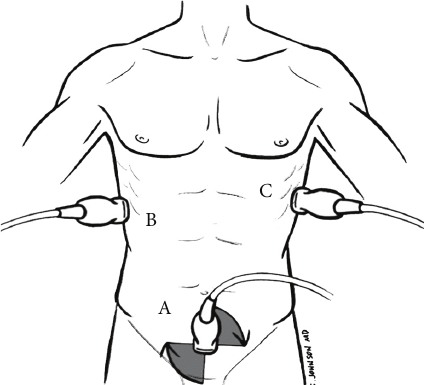
Figure 4: Postrenal/renal assessment: bladder and kidneys. Either a curvilinear or phased-array probe can be used to assess the bladder andkidneys.A=suprapubicviewforbladdervolumeandFoleybulb position, B = RUQ hepatorenal view, and C = LUQ splenorenal view. Adapted from Perera et al. with the authors’ permission